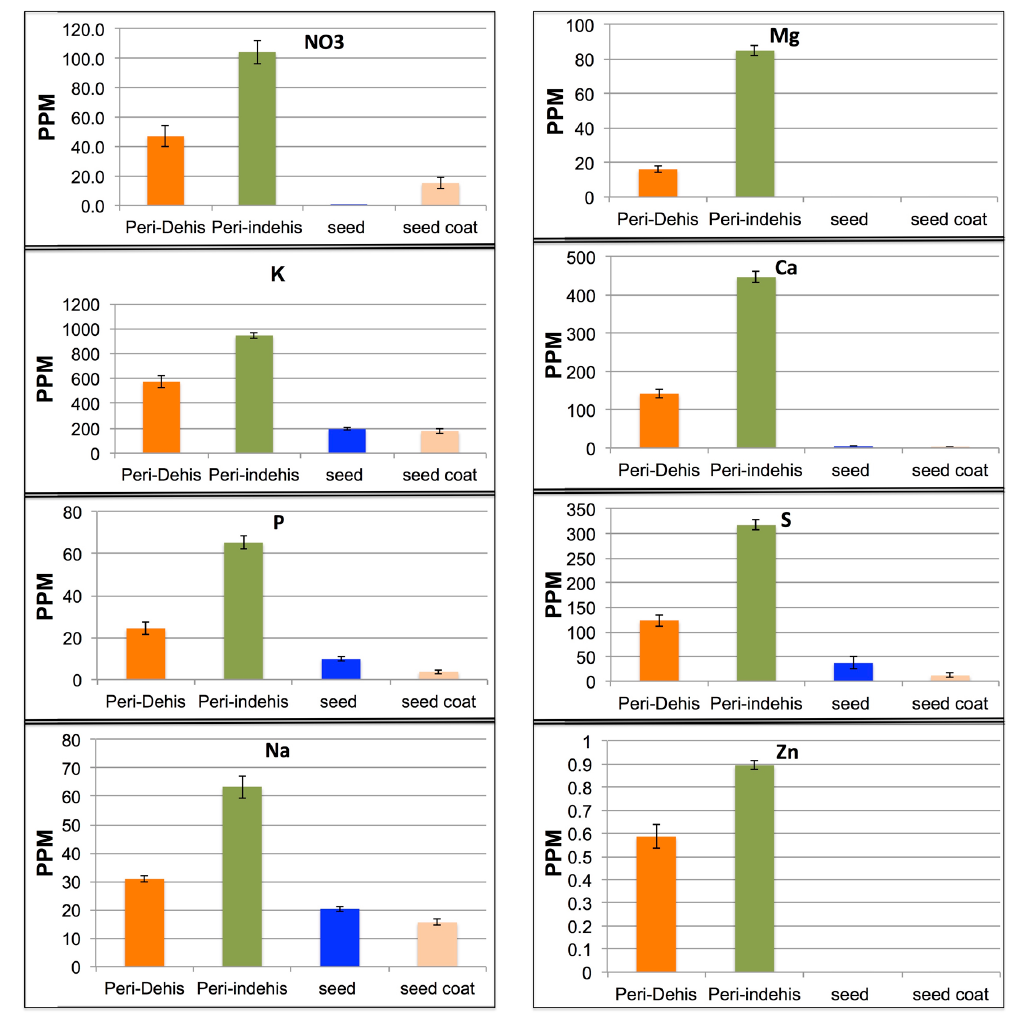
Figure 5. High levels of nutrients are stored and released from dead pericarps of S. alba upon hydration. Extracts derived from intact seeds, seed coats, dehiscent pericarps (Peri-Dehis) and indehiscent pericarps (Peri-indehis) were subjected to nutrient detection by ICP-OES. The concentration (ppm) of each element examined is shown. Bars represent the standard error.